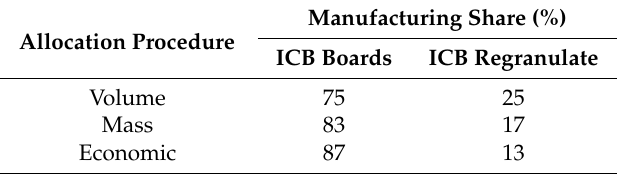
Table 7. Manufacturing share of ICB boards and ICB regranulate depending on the allocation procedure